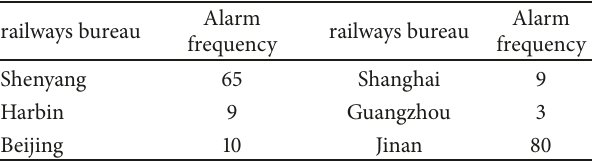
Figure 1: The distribution of equivalent conicities for bogie frame of lateral instability. Table 1: Statistical data of bogie frame lateral